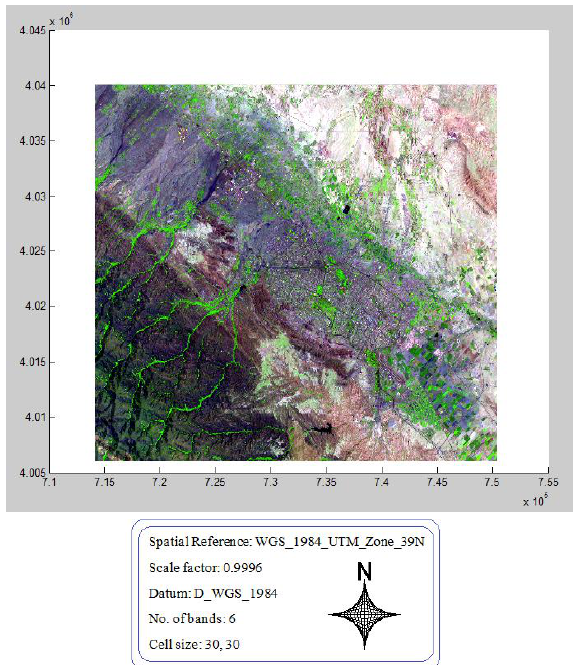
Figure 3. The second Landsat OLI-TIRS satellite image of the study area acquired at March 24,